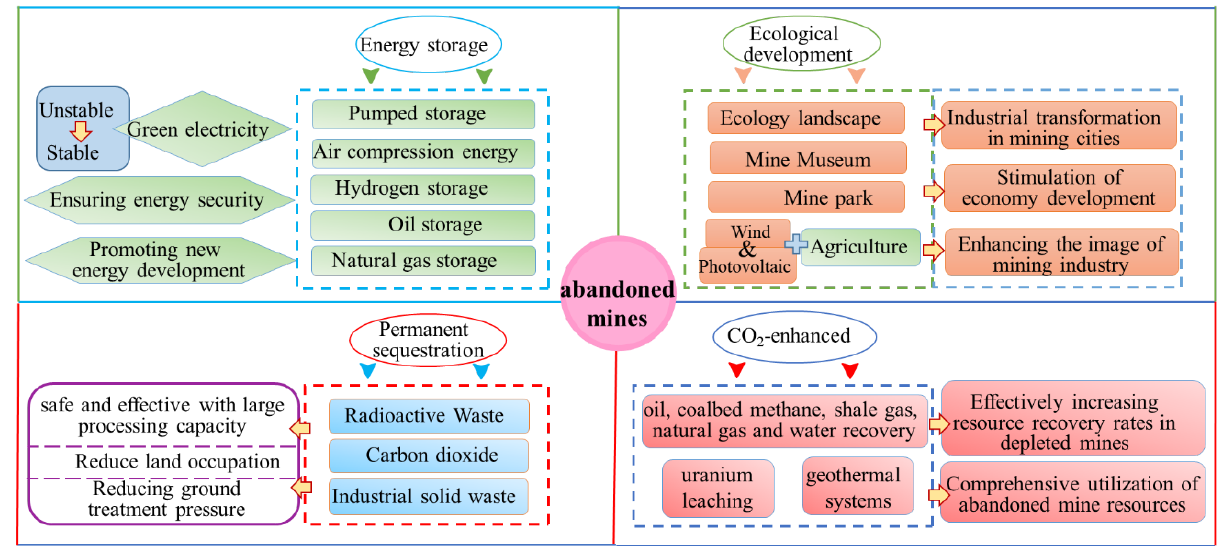
Figure 2. Abandoned mine utilization mode.